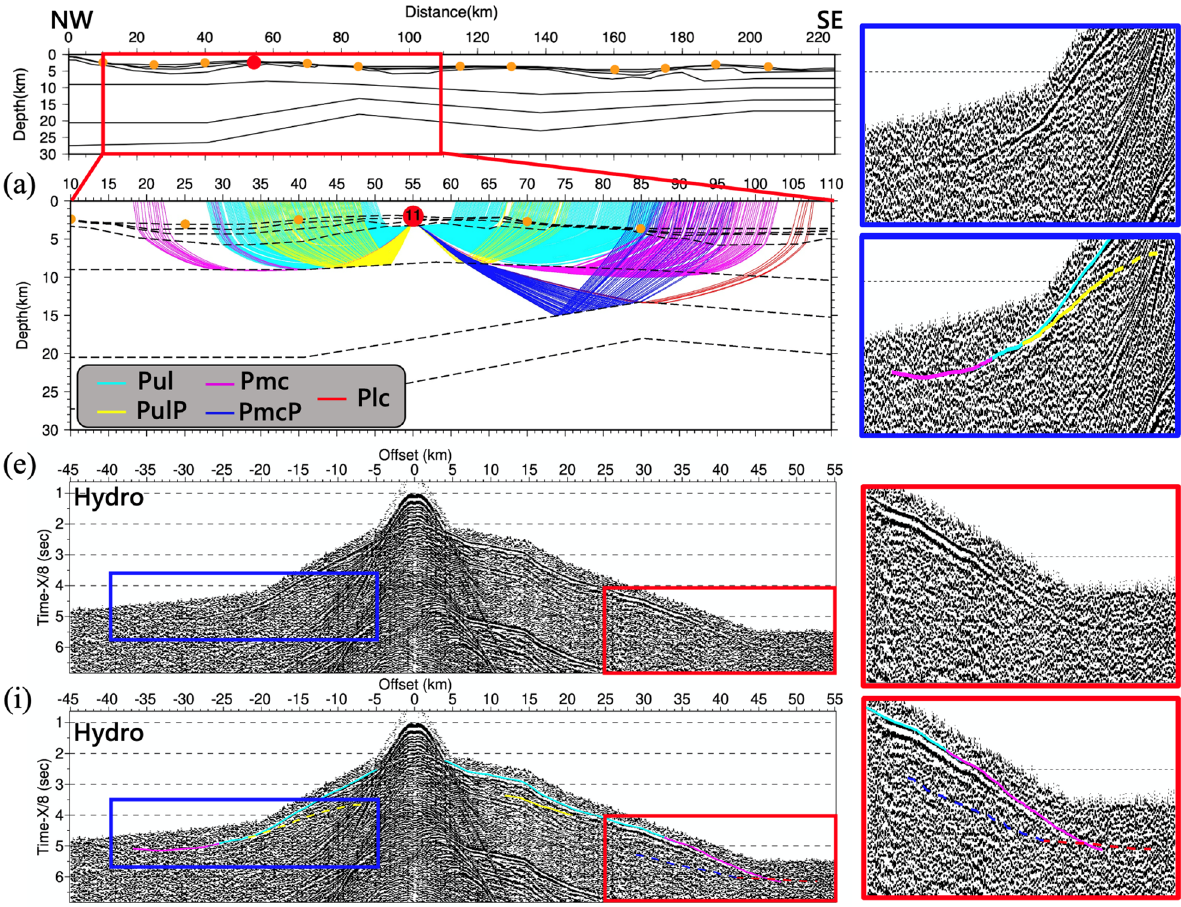
Fig. 8 The ray coverage of the picked arrivals from a OBS11, b OBS10, c OBS07, and d OBS02 station along MGL0906‑22. The hydrophone component of e OBS11, f OBS10, g OBS07, and h OBS02 data without interpretation along MGL0906‑22. The picked arrivals propagating through the crust superimposed on the i OBS11, j OBS10, k OBS07, and l OBS02 data along MGL0906‑22. The OBS images of the blue and red frames respectively at the NW and SE offsets are zoomed in. The labels for arrivals are the same as those in Fig. 7. The dashed lines indicate less reliable picks. The red arrow in Fig. 8j indicates where the curve of the first arrival varies a